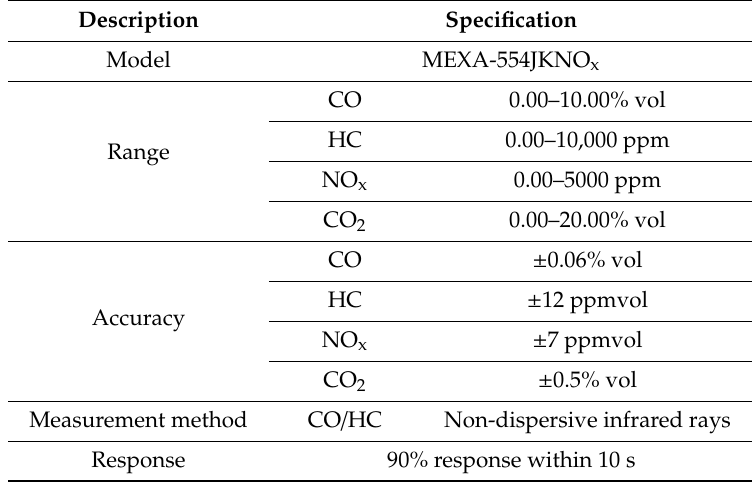
Table 2. Specifications of emission measurement devices.